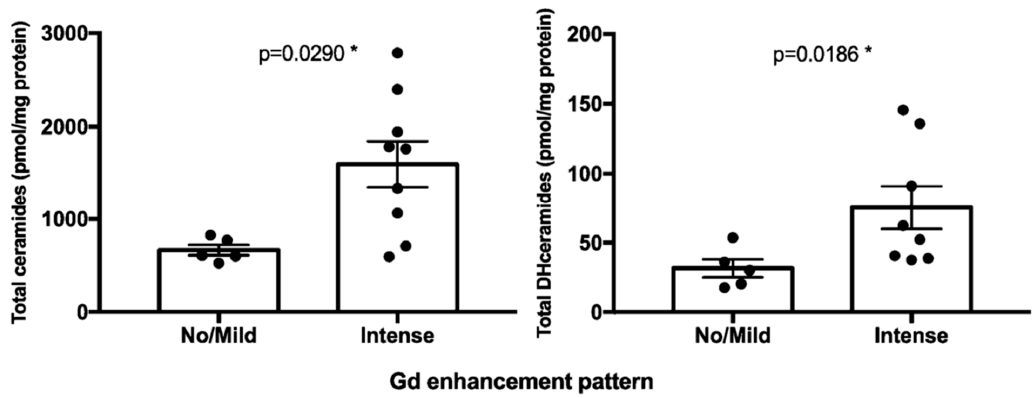
Figure 4. Bar graphs, with SEM, showing the content of total ceramides (*, left) and dihydroceramides (*, right) species according to MR contrast enhancement (no/mild and intense contrast enhancement chordoma groups). *, p ≤ 0.05.